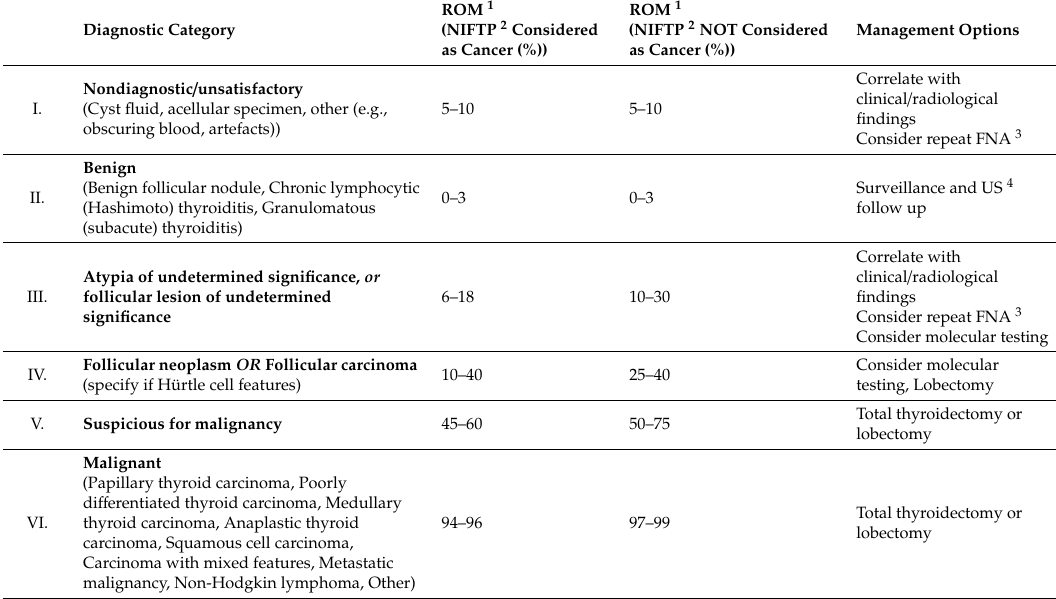
Table 1. The revised 2017 Bethesda System for Reporting Thyroid Cytopathology (TBSRTC) [81].